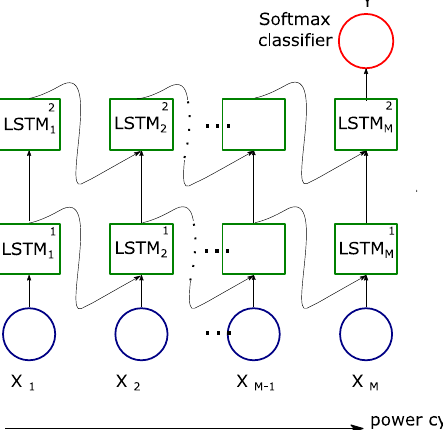
Figure 8. RNN structure with Long Short-Term Memory model (LSTM) layers proposed by Nguyen et al. [15].